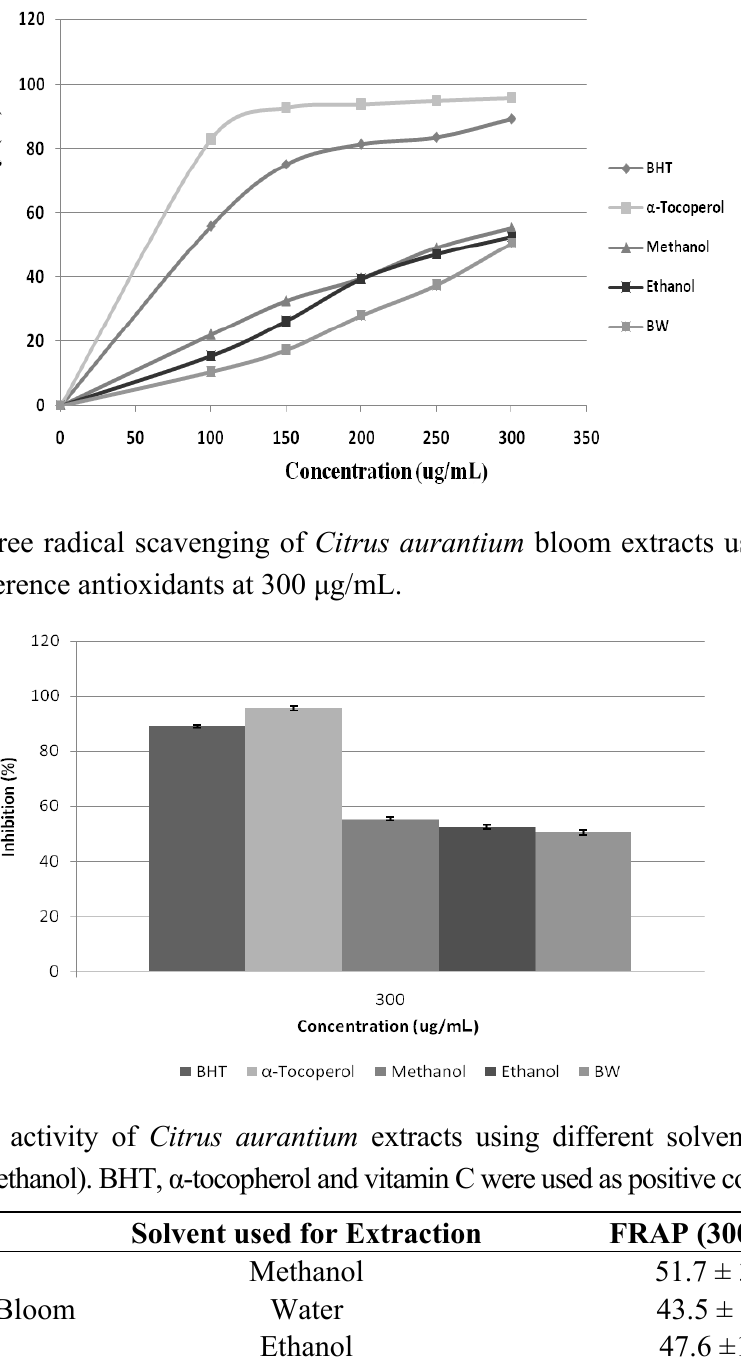
Figure 4. Free radical scavenging activity of Citrus aurantium extracts using different